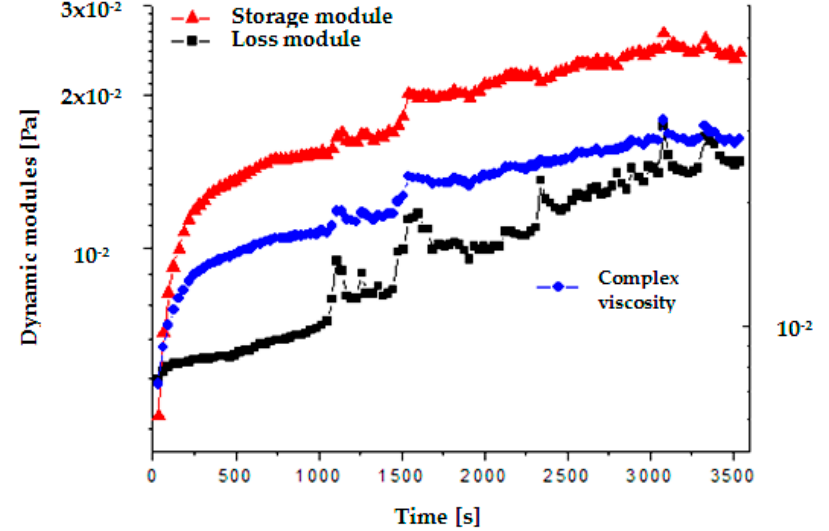
Figure 10. Storage module, loss module and complex viscosity for EM_4a, measured 24 h from manufacturing.